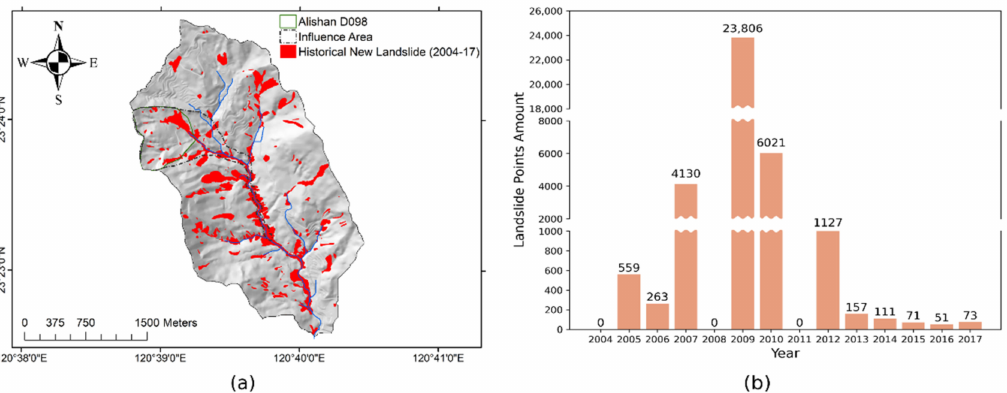
Figure 3. ( a ) The new landslide distribution; ( b ) the number of grid points by year in the sub-basin.